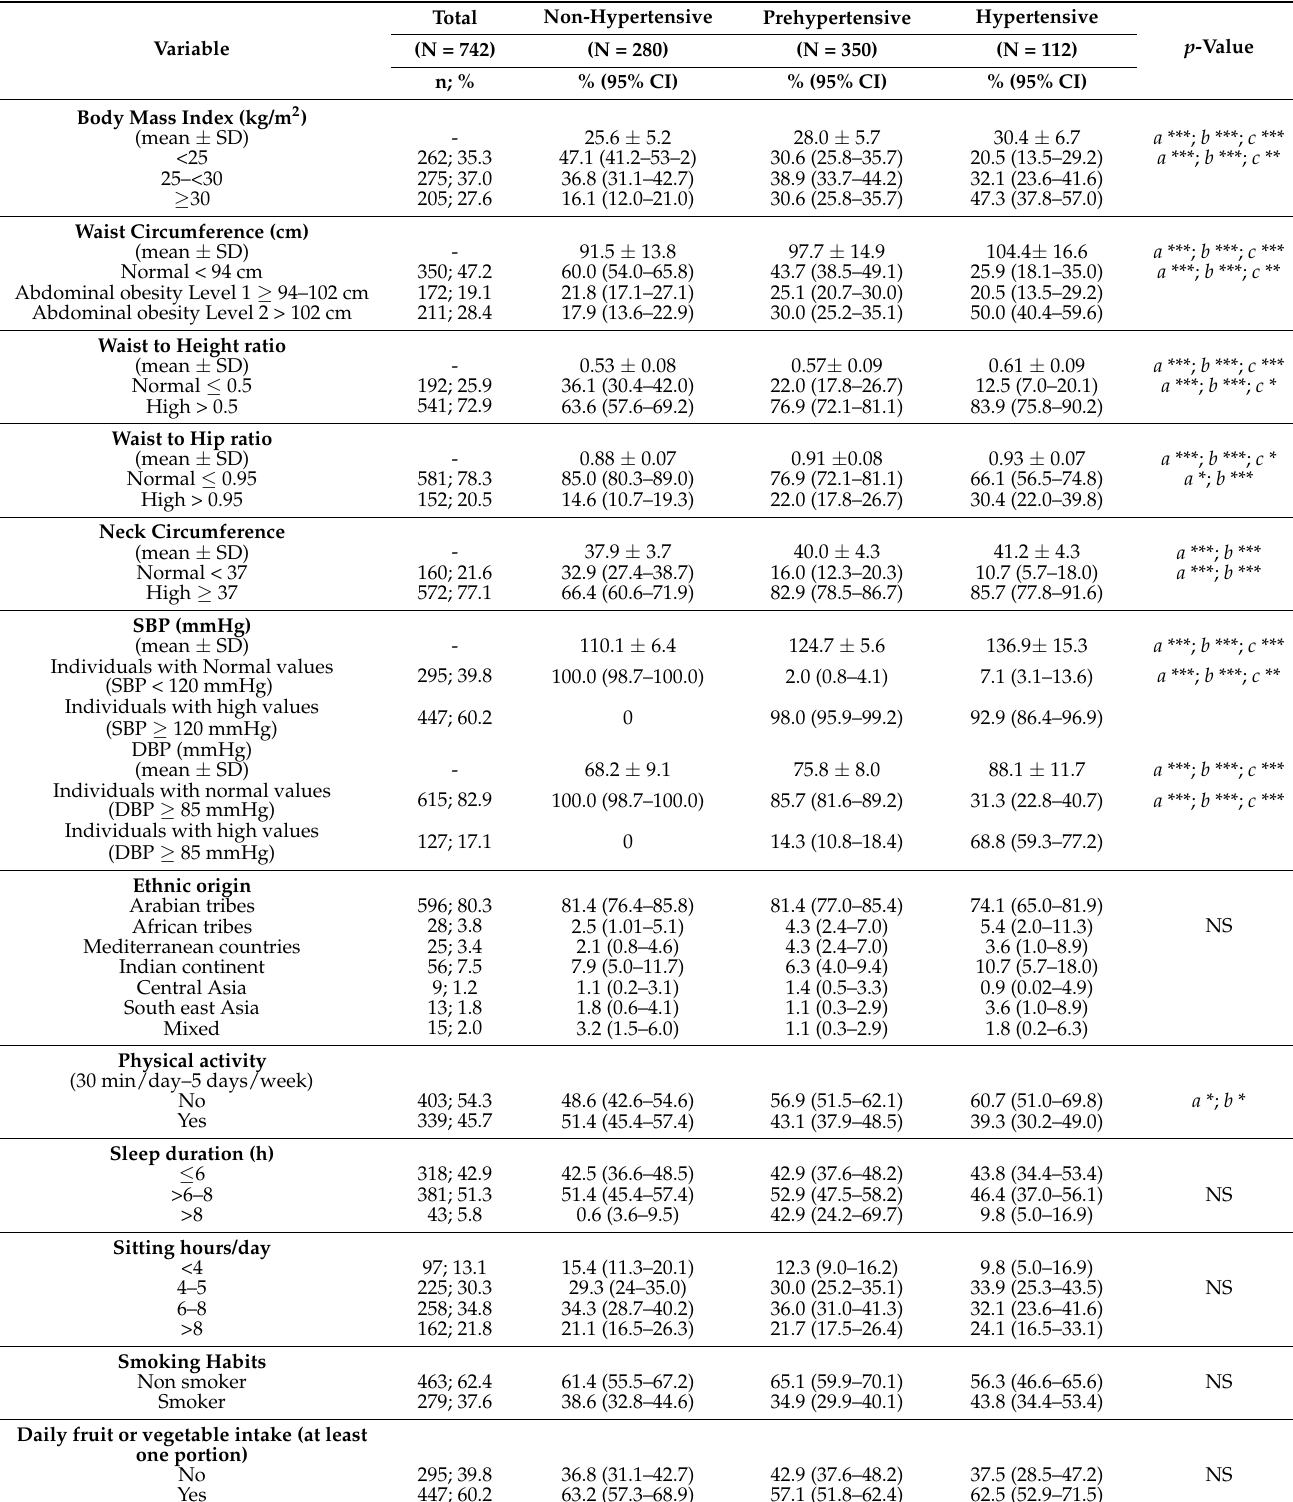
Table 2. Association between demographic, lifestyle, vital signs, and anthropometric characteristics with prehypertension and hypertension in the male